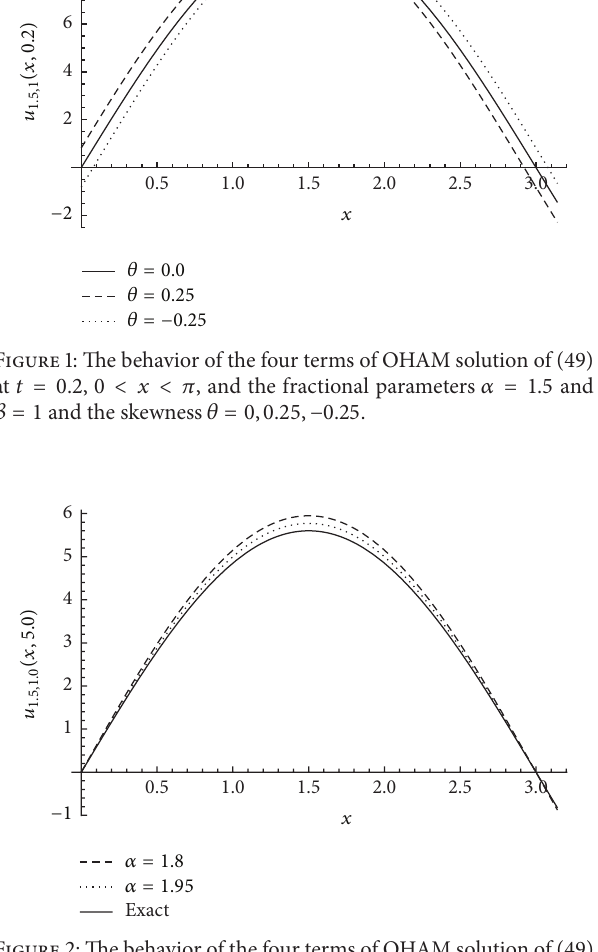
Figure 2: The behavior of the four terms of OHAM solution of (49) at 𝑡 = 0.2 , 0 < 𝑥 < 𝜋 , and the fractional parameters 𝜃 = 0 , 𝛽 = 1 , and 𝛼 = 1.8, 1.95 , compared with the exact solution.